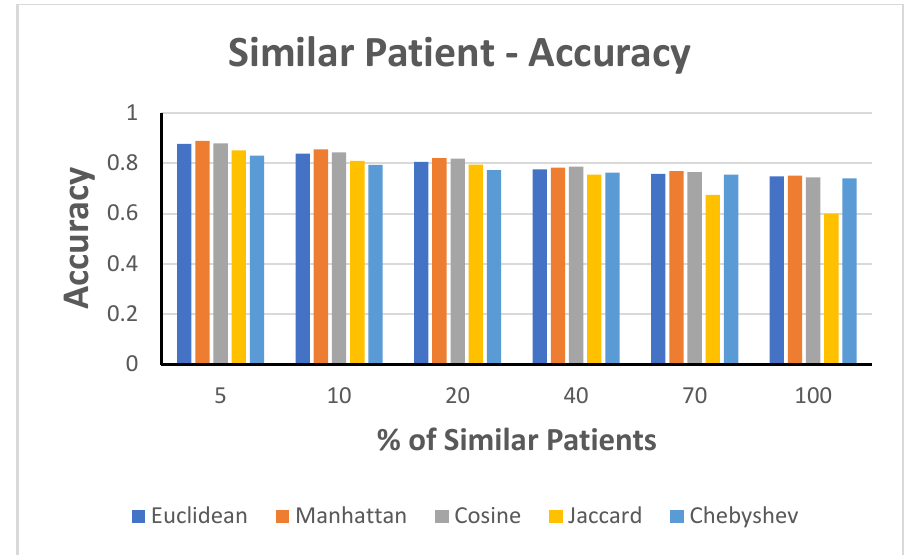
Figure 7. Accuracy with varying training data involving similar patients.